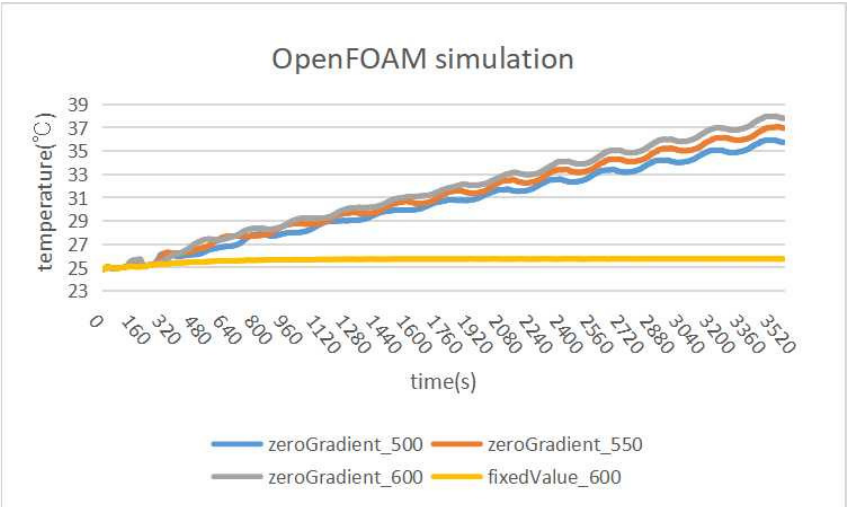
Figure 17. OpenFOAM simulation